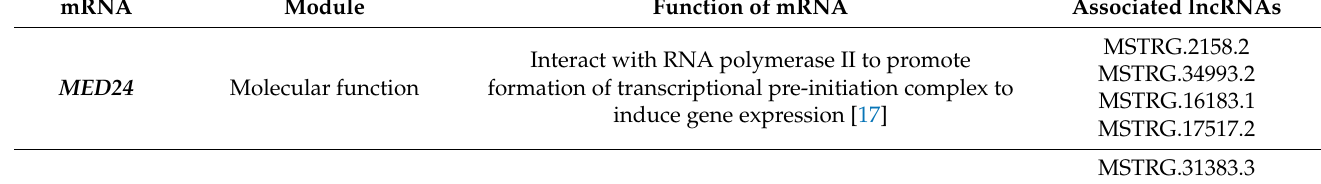
Table 6. Hub genes (target genes of lncRNAs) and associated lncRNAs in the same module. mRNA